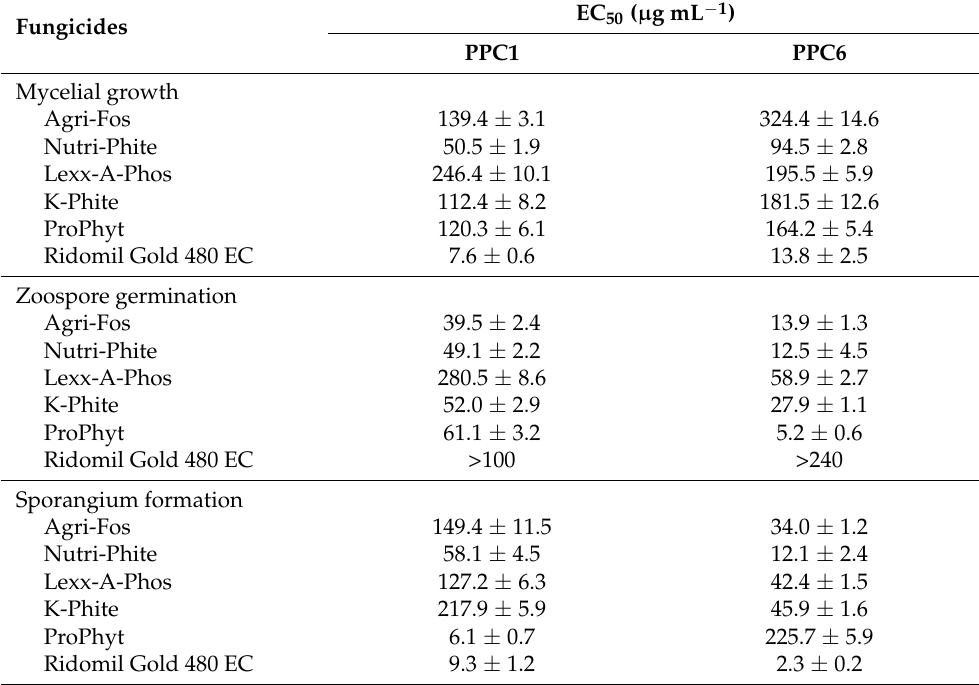
Table 2. EC 50 values of different phosphorous-acid-containing products for Phytophthora capsici mycelial growth, sporangium formation, and zoospore cyst germination *. Fungicides